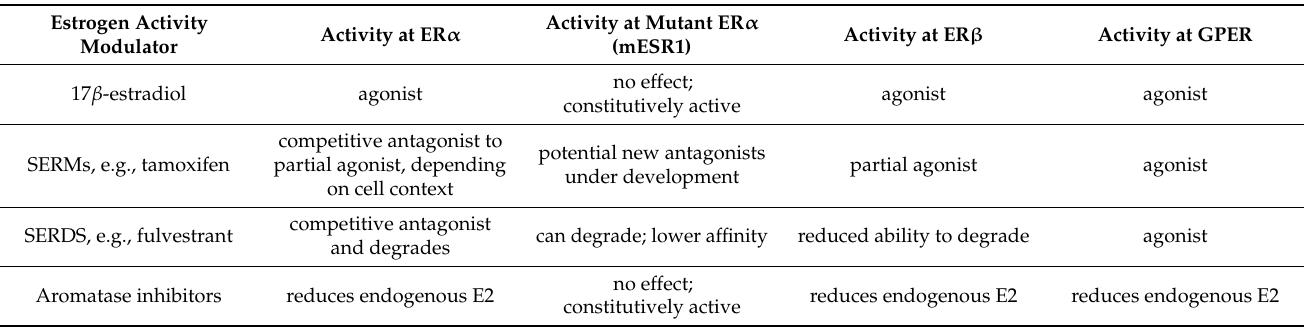
Table 1. Summary of effects of estrogen ligands at distinct estrogen